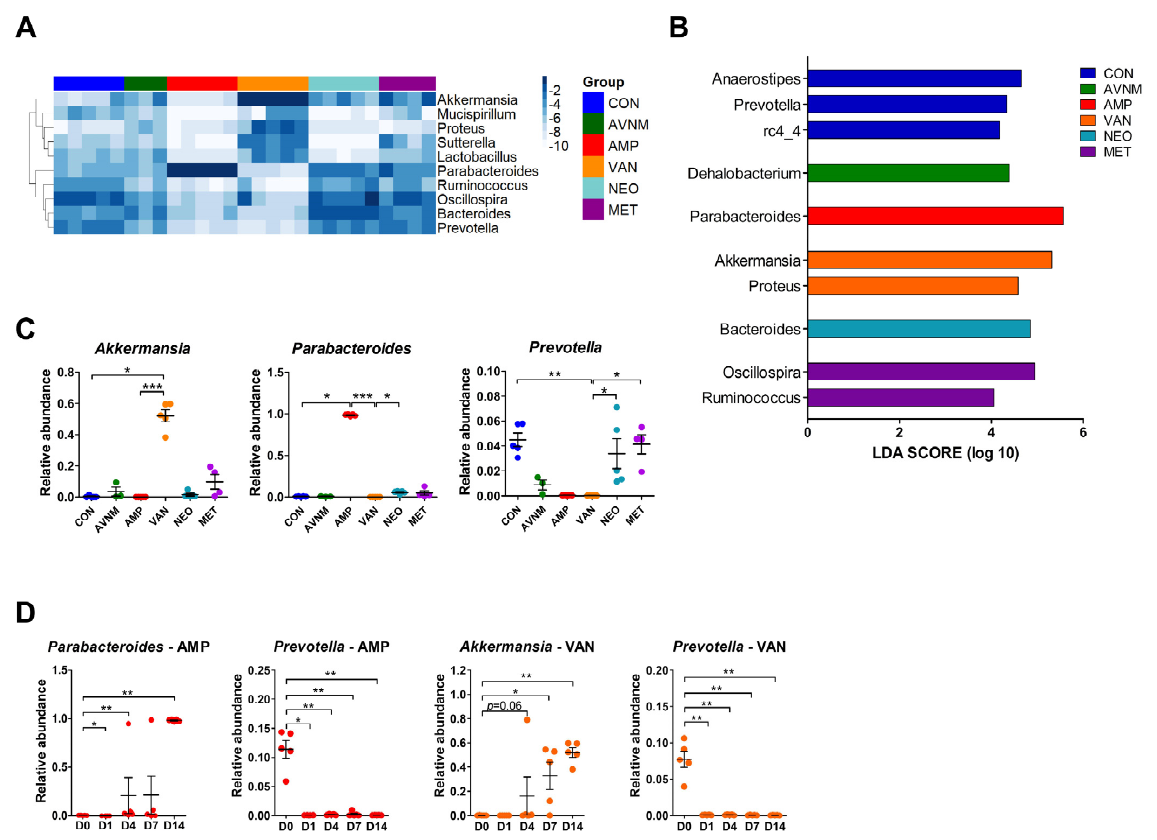
Figure 2. Dominant taxa comparison of each antibiotic group on Day 14 after the start of antibiotic treatment. ( A ) Heatmap of -log of relative abundance of top 10 abundant genera. ( B ) Histograms of the linear discriminant analysis (LDA) scores for abundant genus in each antibiotic-treated group. ( C ) Relative abundance of major discriminative taxa in AMP and VAN groups. ( D ) Relative abun- dance of Parabacteroides , Prevotella , and Akkermansia by date from antibiotic treatment. Data are ex- pressed as the mean ± SEM. Asterisks indicate a statistically significant difference (* p < 0.05; ** p < 0.01; *** p < 0.001 Kruskal–Wallis one-way analysis of variance with the Dunn’s post hoc test. The LDA score cut-off was set to 2.0; CON, control; AVNM, mixture of ampicillin, vancomycin, neomy- cin and metronidazole; AMP, ampicillin; VAN, vancomycin; MET, metronidazole).